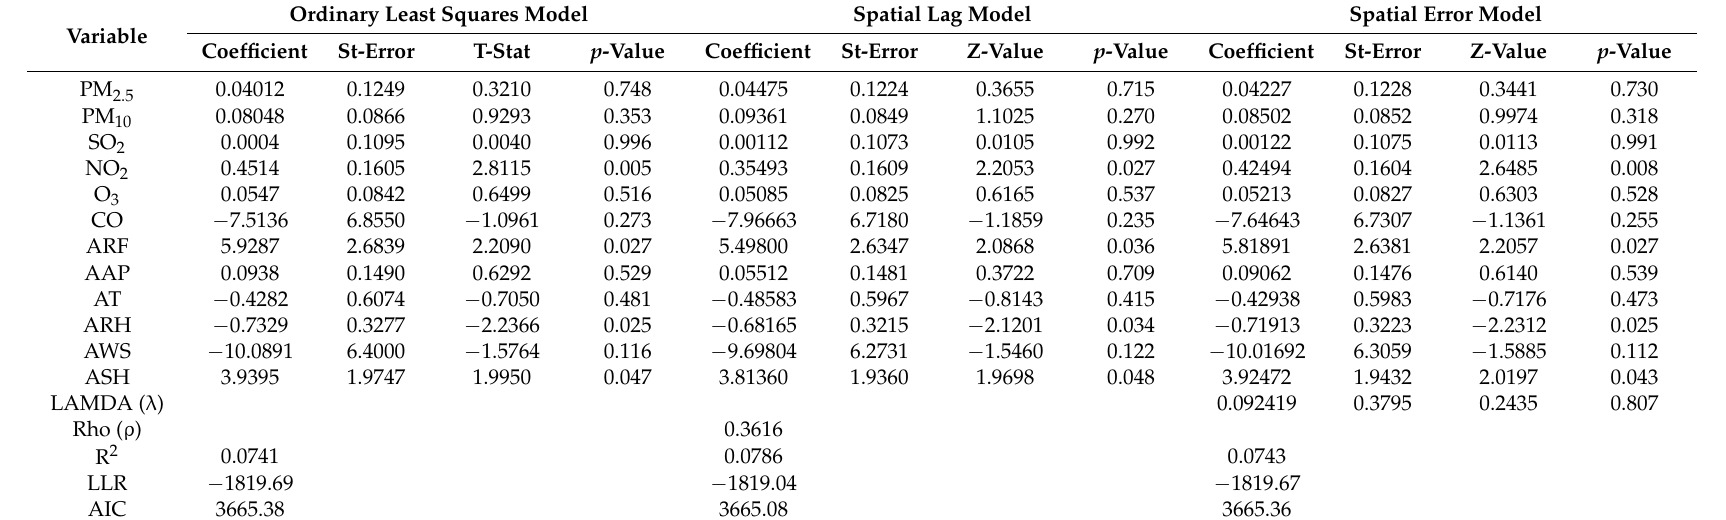
Table 2. Results of the OLS model, spatial lag model (SLM) and SEM assessing the correlates of scarlet fever with the maximum likelihood